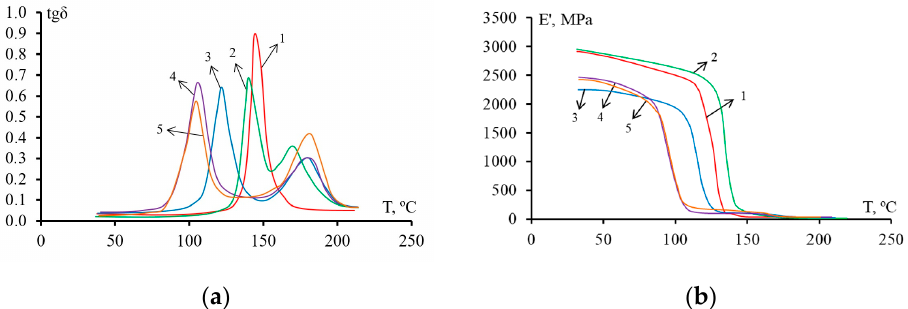
Table 2. Glass transition T g temperatures of epoxy matrices modified with PSU and FGE obtained by DMA and DSC methods.